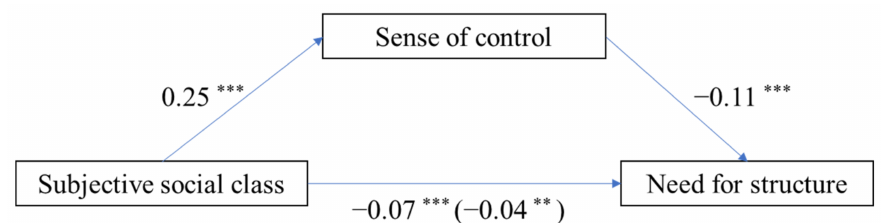
Figure 5. Model of the mediating role of perceived control in the association between subjective social class and need for structure; ** p < 0.01, *** p < 0.001.